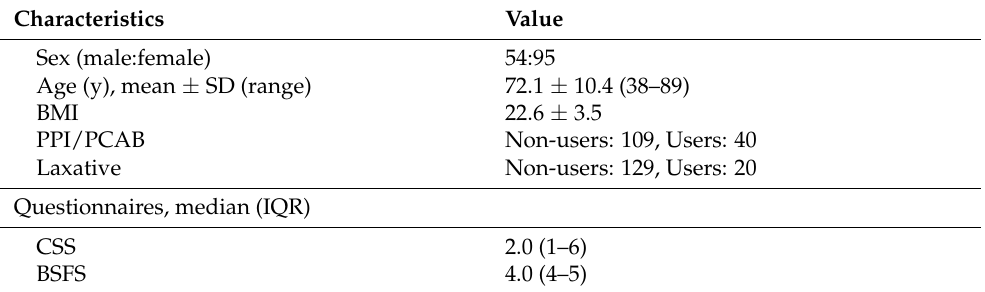
Table 1. Clinical characteristics of study patients (n = 149).